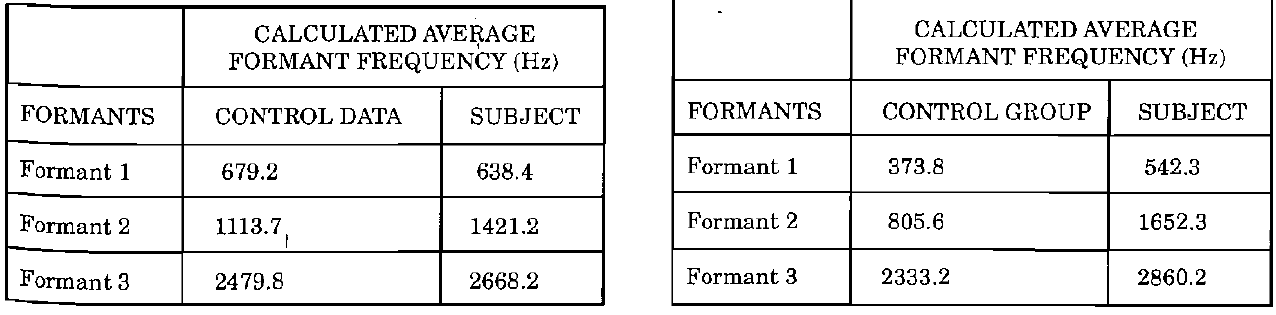
TABLE 9: Average formant frequencies (in Hz) of the control data and the subject of [a]